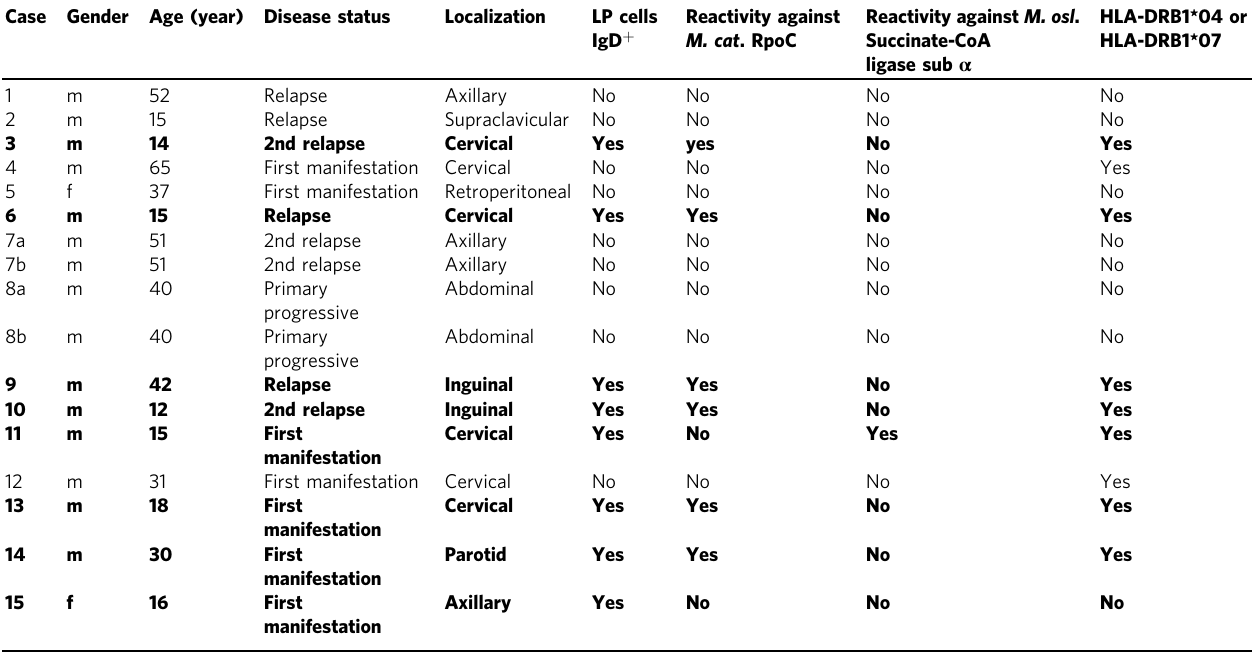
Bold: IgD + NLPHL; cases 7 and 8: (a) NLPHL, (b) histological transformation into DLBCL in the same lymph